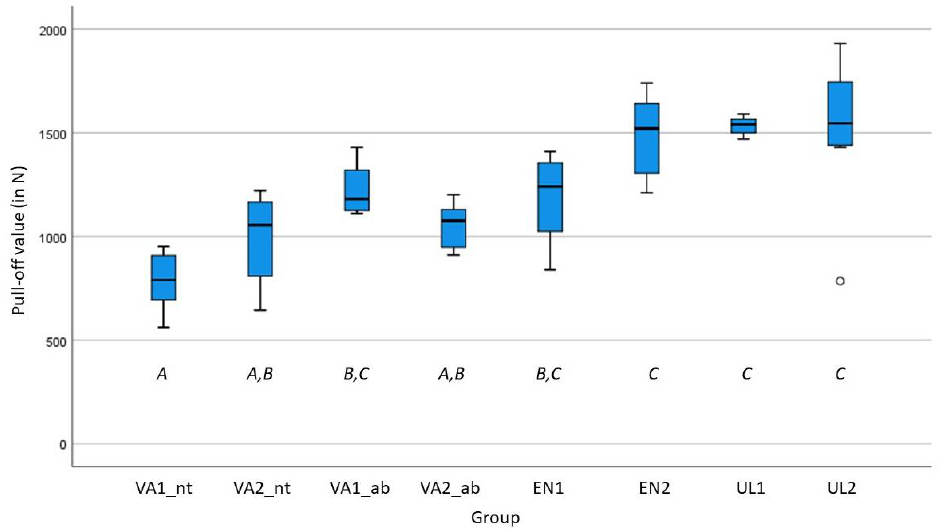
Figure 8. Boxplot diagram showing the pull-off force values [N] of all test groups and their group distribution ( A–C ). Table 2. Overview of group-specific pull-off force values, their statistical classification (group dis-